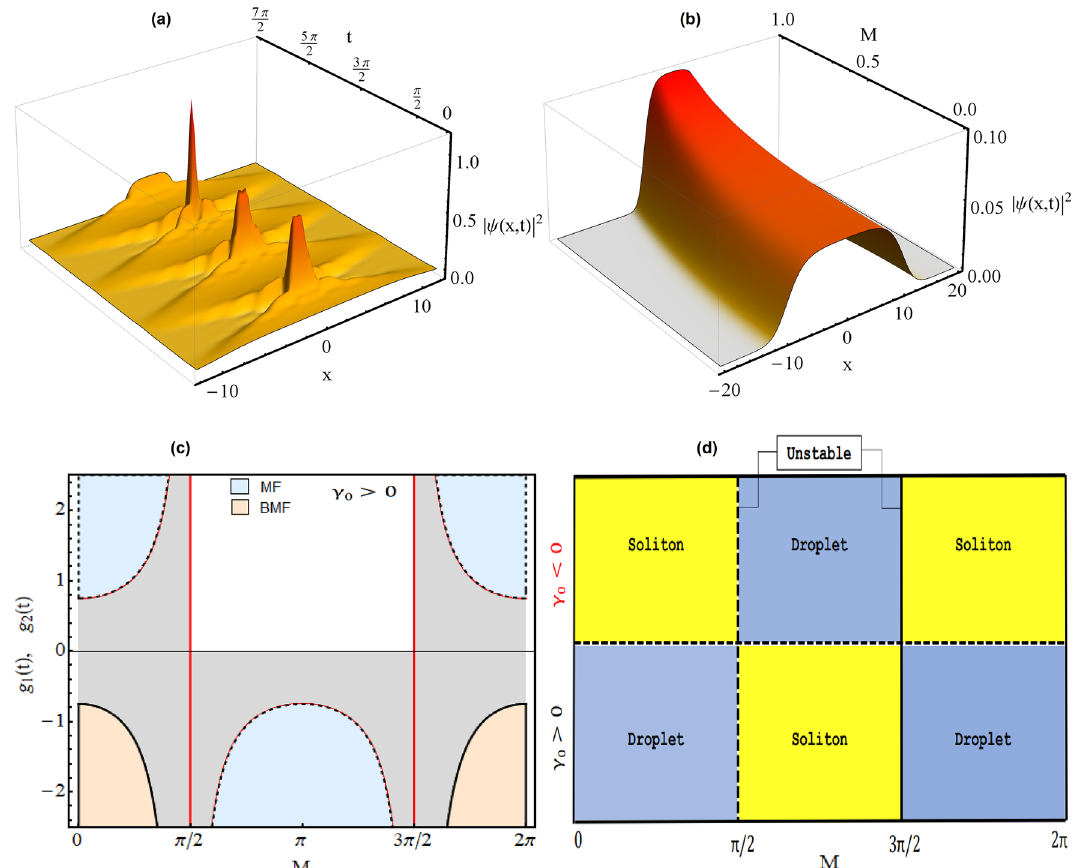
Figure 2. Quantum droplet to soliton transition in regular harmonic trap. The condensate densities are displayed with varying (a) time ( t ) with M dashed line) and BMF interactions ( g 1 ( t ) , thick line) w.r.t. M at t